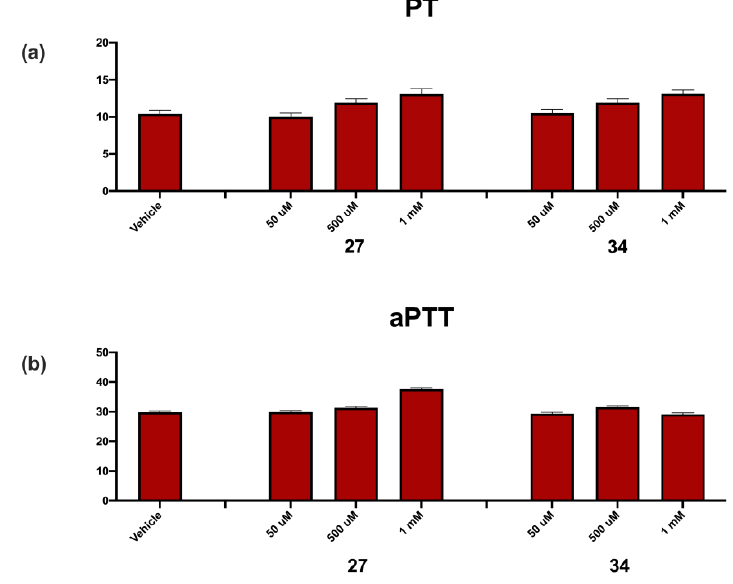
Figure 7. ( a ) PT and ( b ) aPTT coagulation parameters for compounds 27 and 34 .